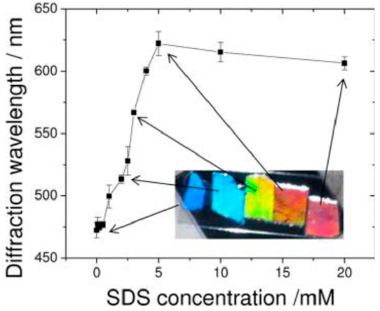
Figure 19. Diffraction wavelength versus sodium dodecyl sulphate (SDS) concentration. Inset: photographs taken close to the Littrow configuration at a 28° angle between source and camera to the 2D array normal [148]. Adapted with permission from Anal. Chem. 84, 6416–6420. Copyright (2012) American Chemical Society.